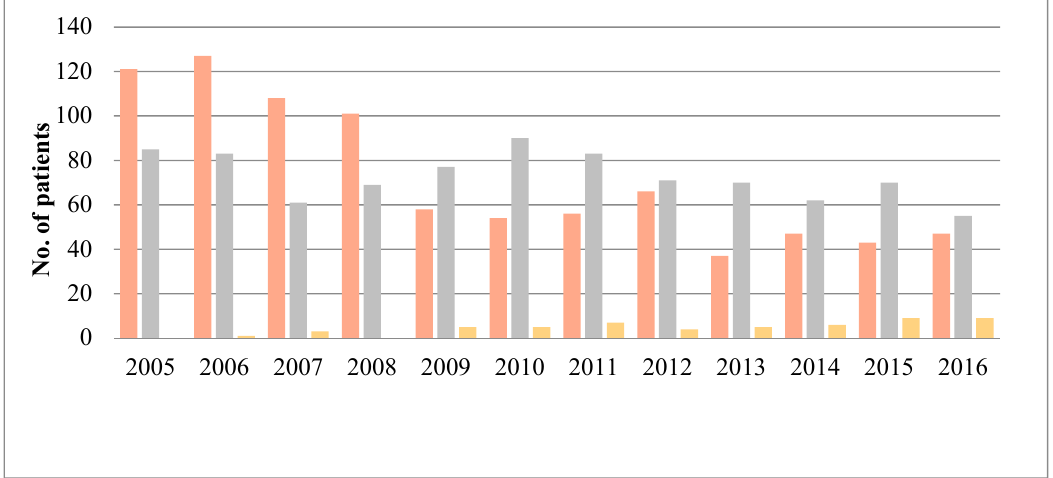
Figure 4. Case-finding patterns among full-time teachers in Zhejiang province, 2005–2016.